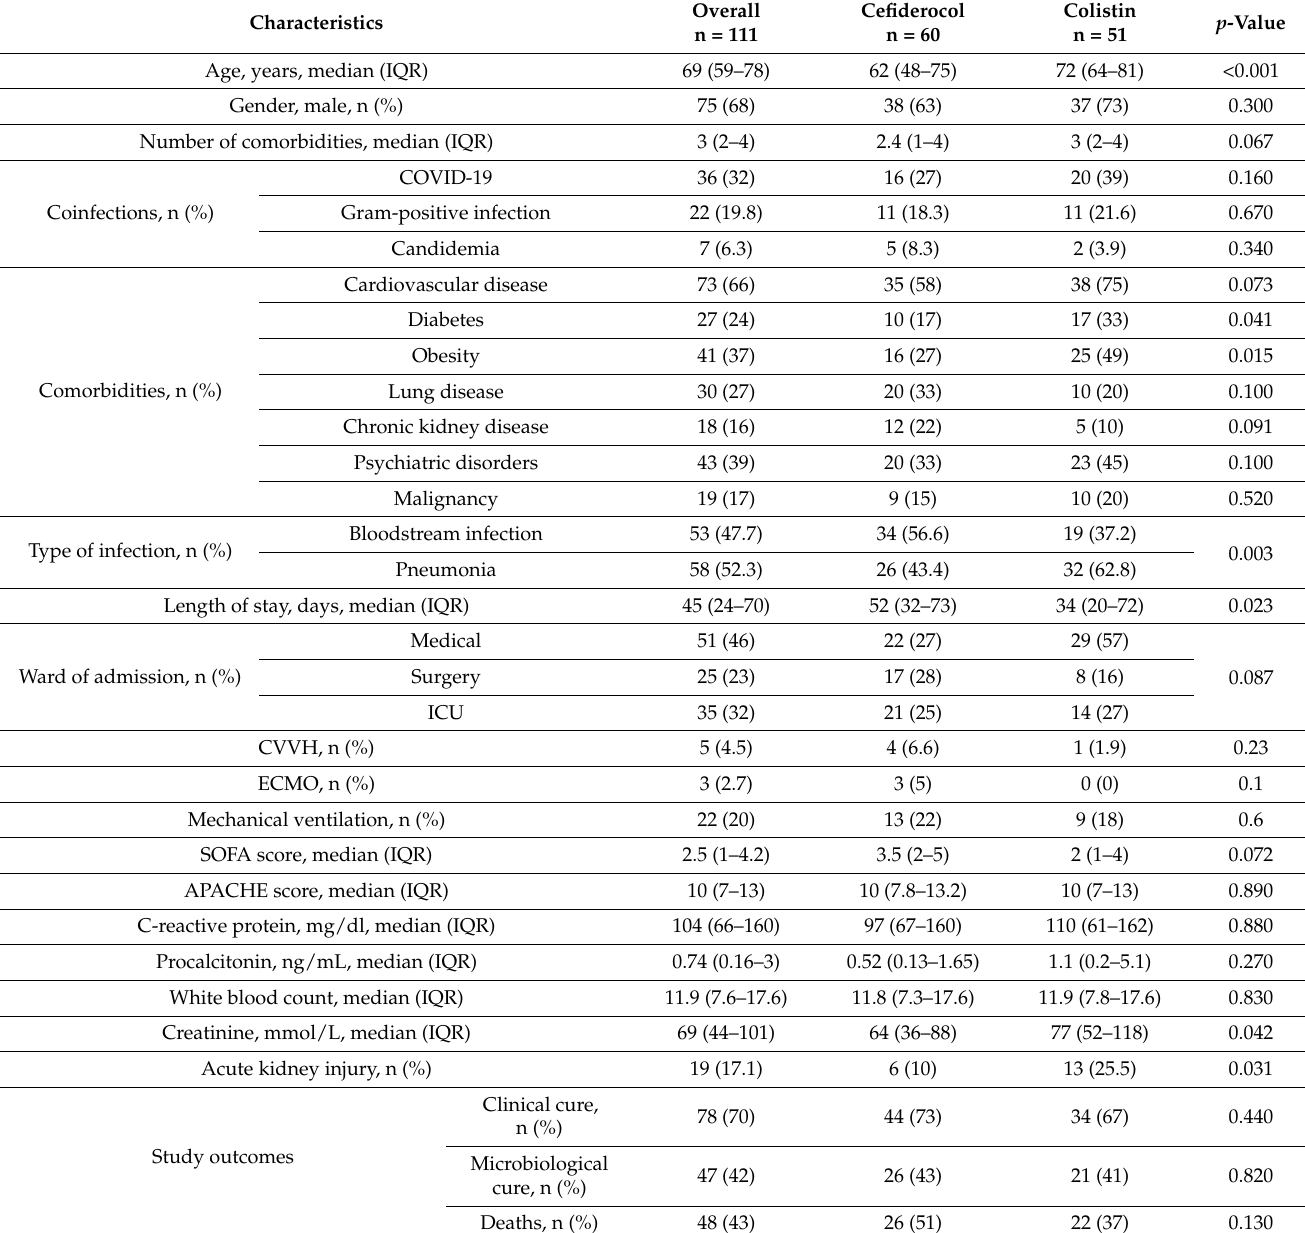
Legend for Table 1: n = number, % = percentage, IQR = interquartile range, ICU = intensive care unit, SOFA = sequential organ failure assessment, APACHE= acute physiological assessment of chronic health evalua-